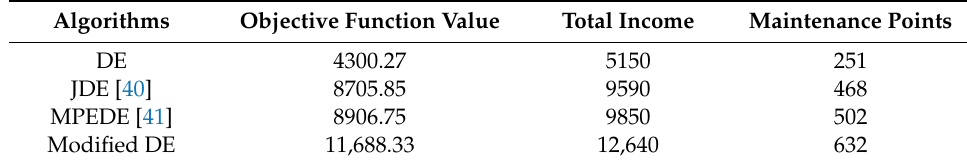
Table 7. Comparison of di ff erent types of